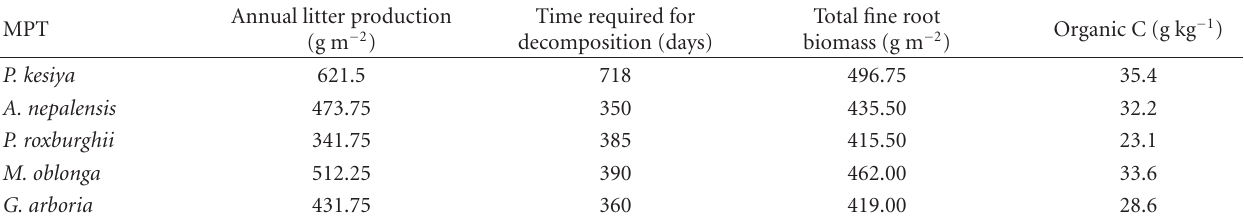
Table 7: Growth, litter production, fine root biomass of promising MPTs in humid tropics, and their contribution on SOC content.